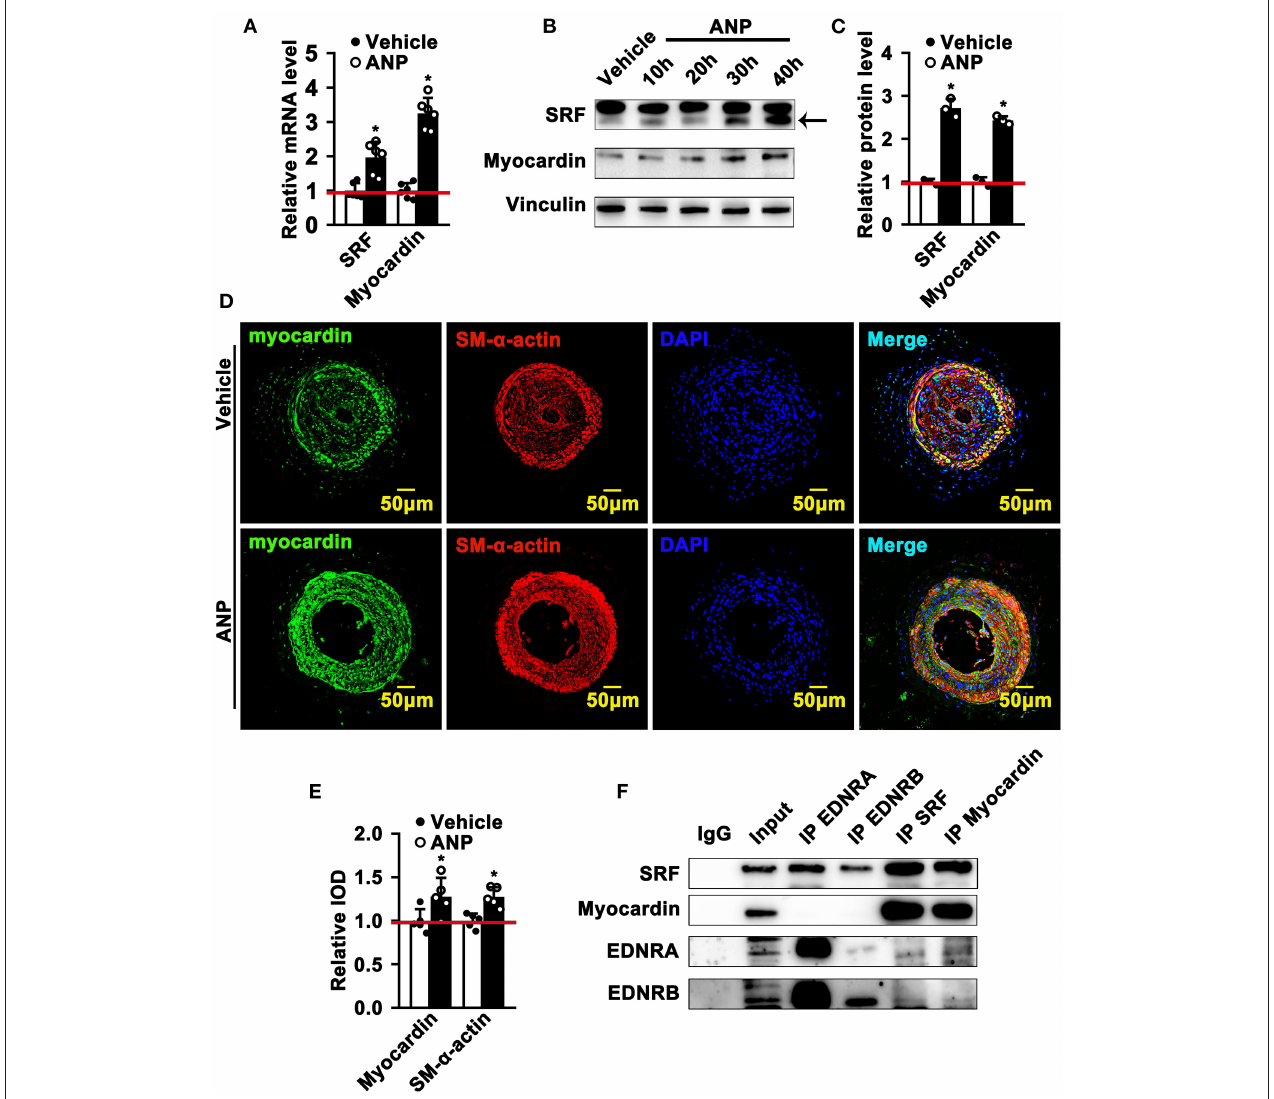
FIGURE 6 | Andrographolide promotes the interaction of EDNRA and EDNRB with the Myocardin-SRF complex. (A) Real-time PCR was performed to determine SRF and Myocardin mRNA levels in SMCs after 5 µ M Andrographolide treatment ( n = 6). (B) Rat SMCs were treated with Andrographolide (5 µ M) over different time points. A western blot assay was performed to evaluate the protein level of SRF and Myocardin, quantified densities of protein were bound by Integral Optical Density (IOD) using ImageQuant TL software (C) ( n = 3). (D,E) Immunofluorescence staining was performed to evaluate the expression of Myocardin in ligated left carotid arteries. (F) Co-immunoprecipitation was performed to determine the interaction of EDNRA/EDNRB and Myocardin-SRF. Total protein from rat SMCs was extracted using RIPA buffer. The cell lysate was precleared using anti-species-specific IgG beads. The precleared cell lysate was incubated with EDNRB (abcam), EDNRA (abcam), Myocardin (Santa Cruz), and SRF (abcam) for 1h at 4 ◦ C. Following incubation with pre-equilibrated protein A/G agarose beads on a rocking platform overnight at 4 ◦ C, the co-immunoprecipitated targets were evaluated by western blotting. * P <